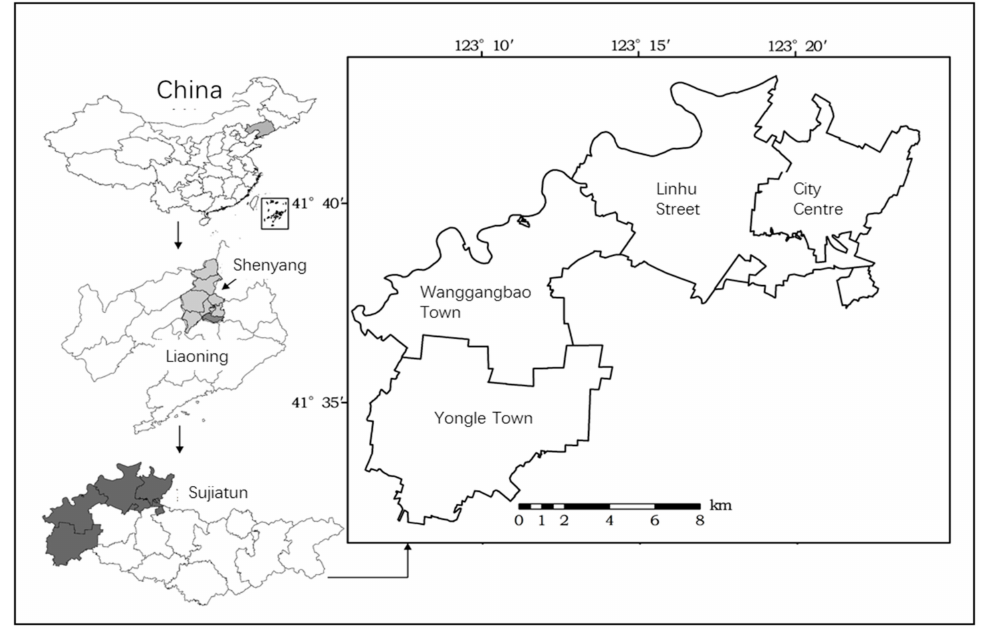
Figure 2. Geographical location of study